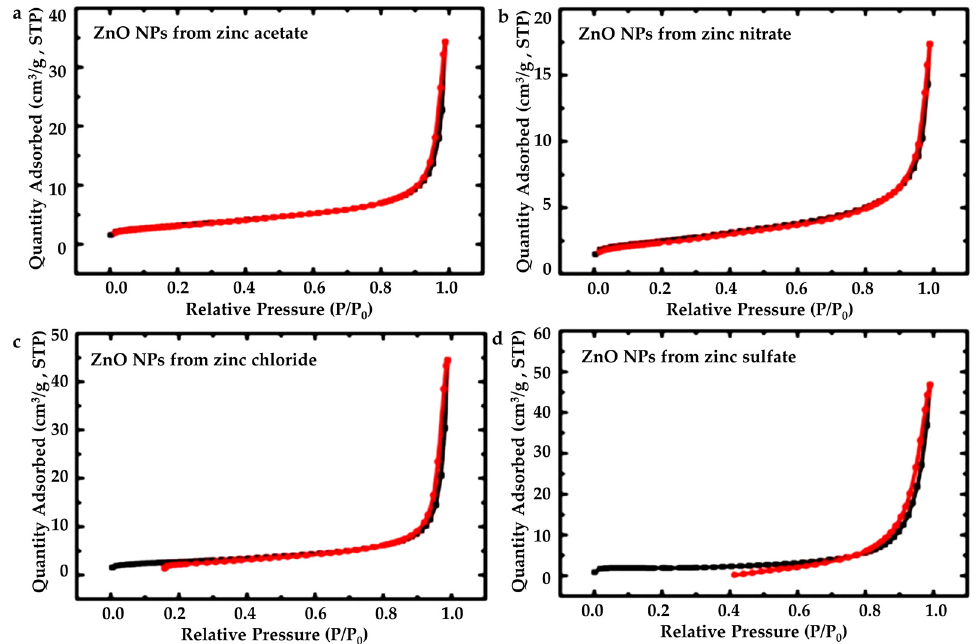
Figure 5. N2-isotherms for the ZnO nanoparticles, structured from all four precursors: ( a ) zinc acetate dehydrate (ZnAc), ( b ) zinc nitrate hexahydrate (ZnNit), ( c ) zinc chloride (ZnChlor), and ( d ) zinc sulphate heptahydrate (ZnSulf).